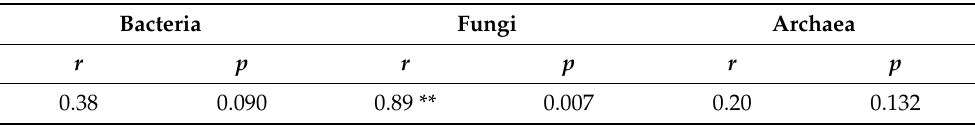
Table 6. Functional differences of microbial community among three stands at the module level of KEGG. Bacteria